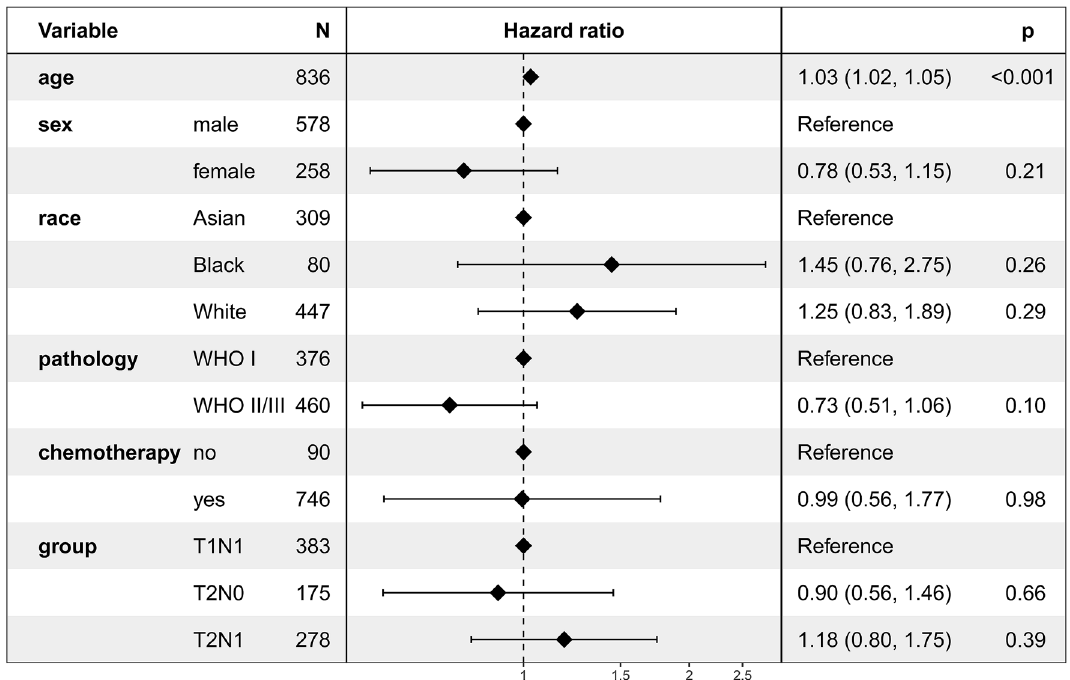
Figure 4. Multivariate regression analysis of the prognostic factors for cancer-specific survival.